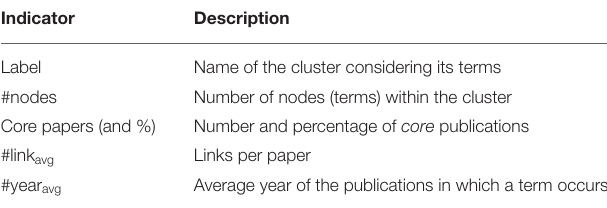
value is not normalized, but the ranking order and the duration of the burst are rather relevant for its interpretation.